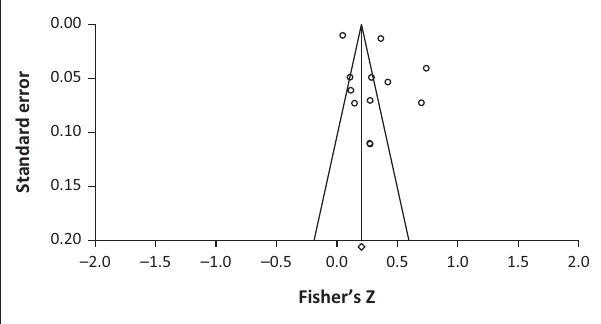
FIGURE 2: Funnel plot depicting publication bias for the association between human resource management and financial